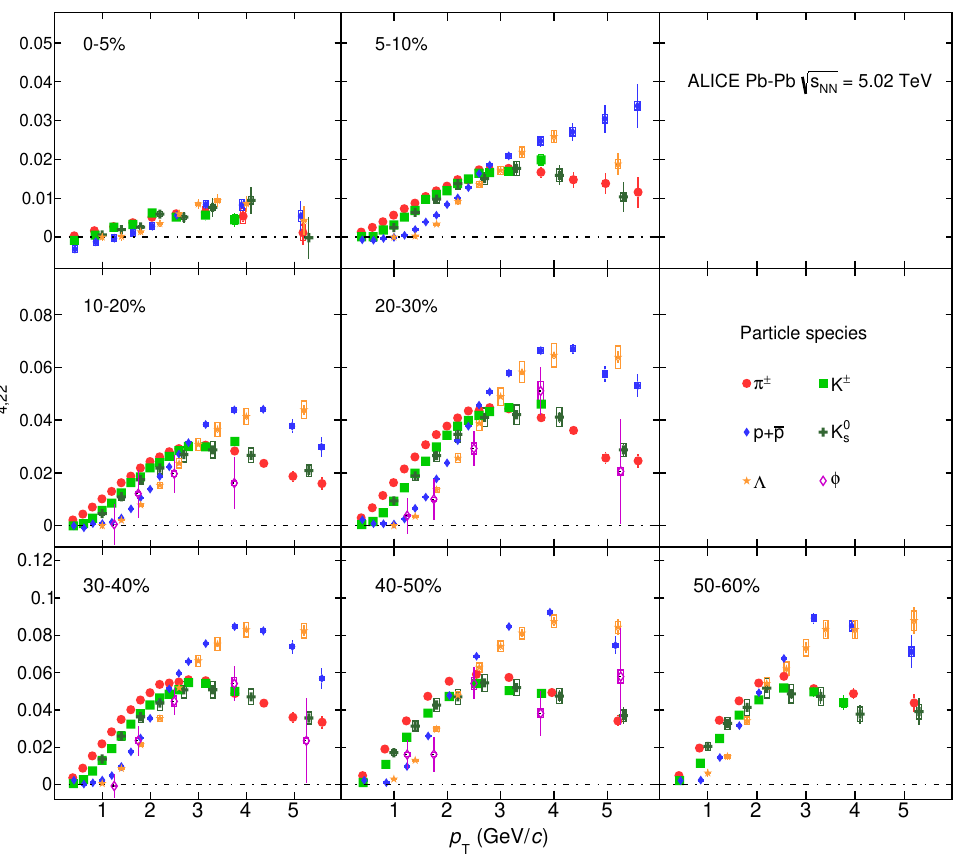
Figure 6 . The p T -di(cid:11)erential v 4 ; 22 for di(cid:11)erent particle species grouped into di(cid:11)erent centrality p intervals of Pb-Pb collisions at s NN = 5 : 02 TeV. Statistical and systematic uncertainties are shown as bars and boxes,